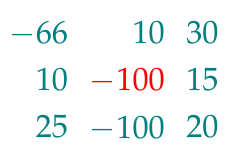
Figure 4. The 2D data subgrid representing ( 3, 3 ) . N 3